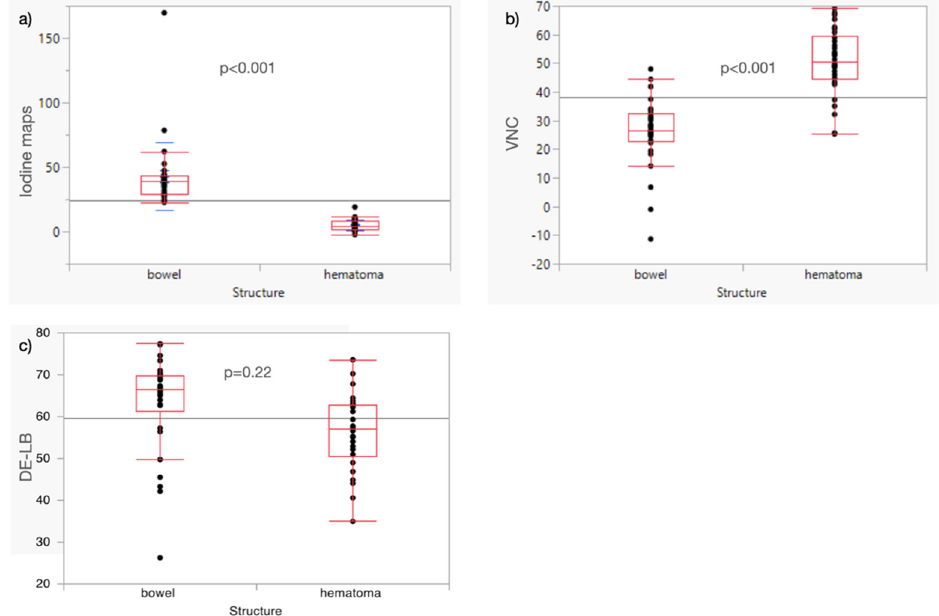
Figure 6. Boxplots show median and quantiles of IM ( a ), VNC ( b ), and DE-LB ( c ). Of note: IM: dual-energy CT-based iodine maps; VNC: dual-energy CT-based virtual non-contrast images; DE-LB: linearly blended dual energy CT images equal to single energy CT images.